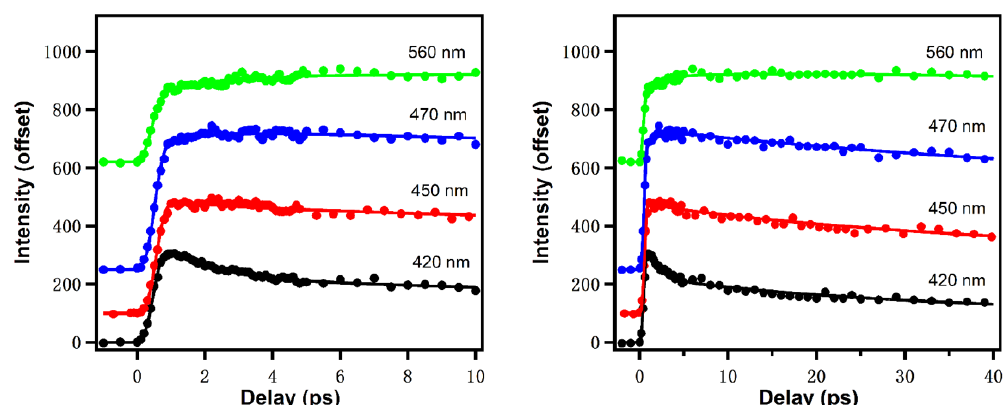
Figure 7. NADH emission at different wavelengths in different time windows (0–10 ps for left and 0–40 ps for right).